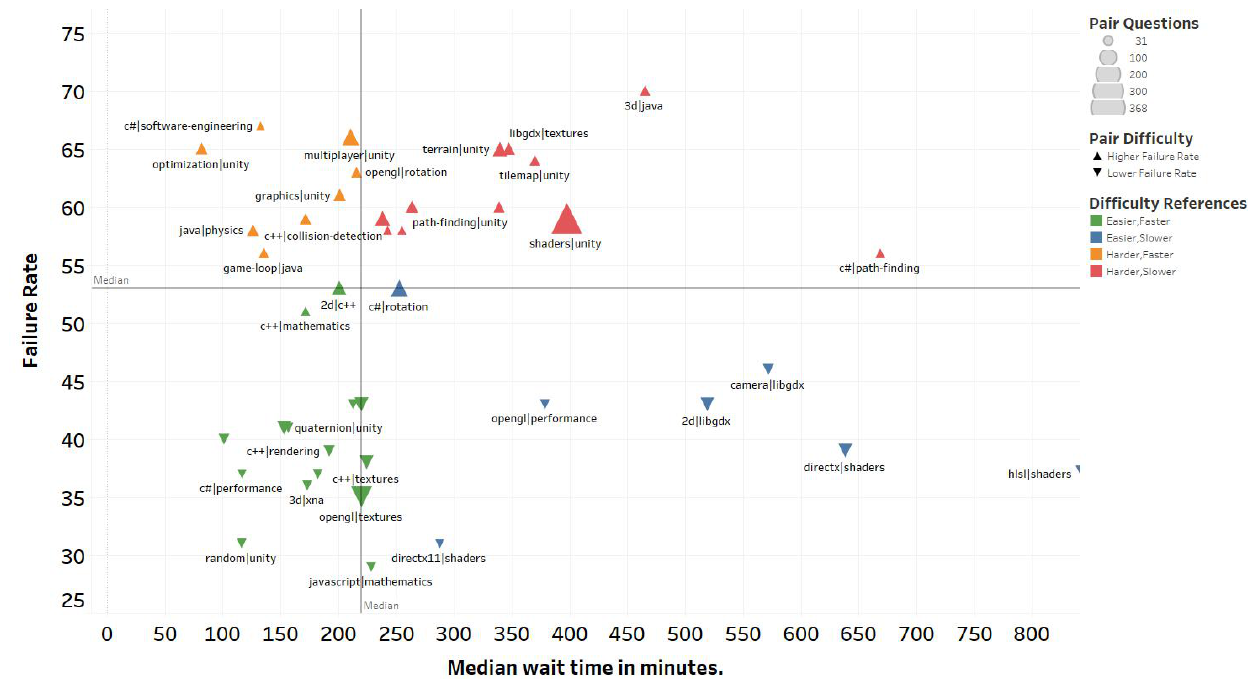
Figure 10. Community support for tech–concept pairs. Upwards (resp. downwards) triangles indicate cases where the pair has a failure rate at least 5 points higher (resp. lower) than any of its constituents. The size of the triangles is indicative of the number of questions for the tag pair. Colours indicate the relative support of the pair in the set of tech–concept